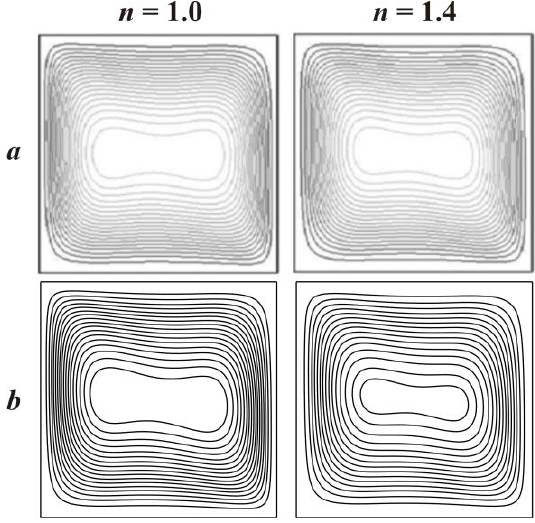
Figure 2. A schematic of the test system.